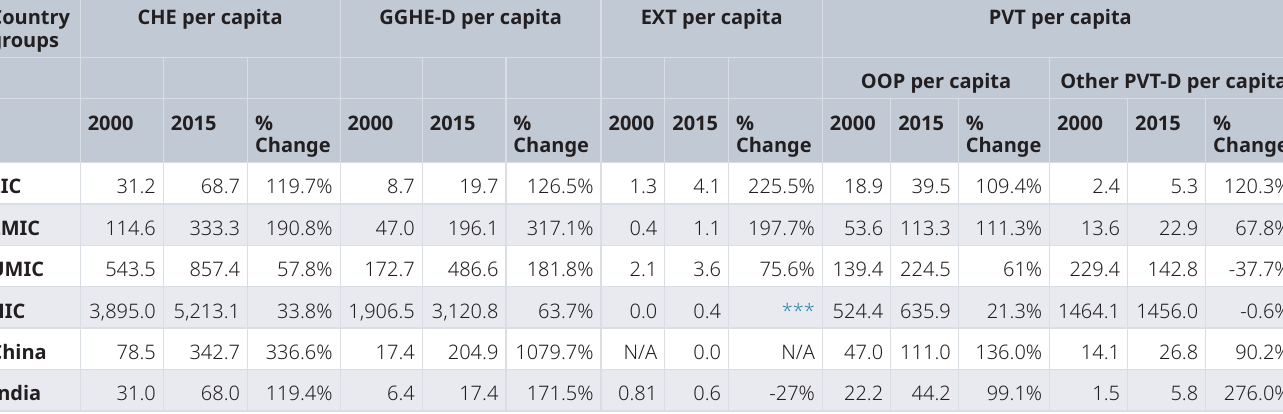
Table 2. Changes in current health expenditures per capita, 2000 and 2015 (in constant 2010 US$). Current health expenditure is the sum of domestic general government health expenditure (GGHE-D), health expenditure from external resources (EXT) and domestic private health expenditure (PVT-D); OOP is a subset of PVT-D.